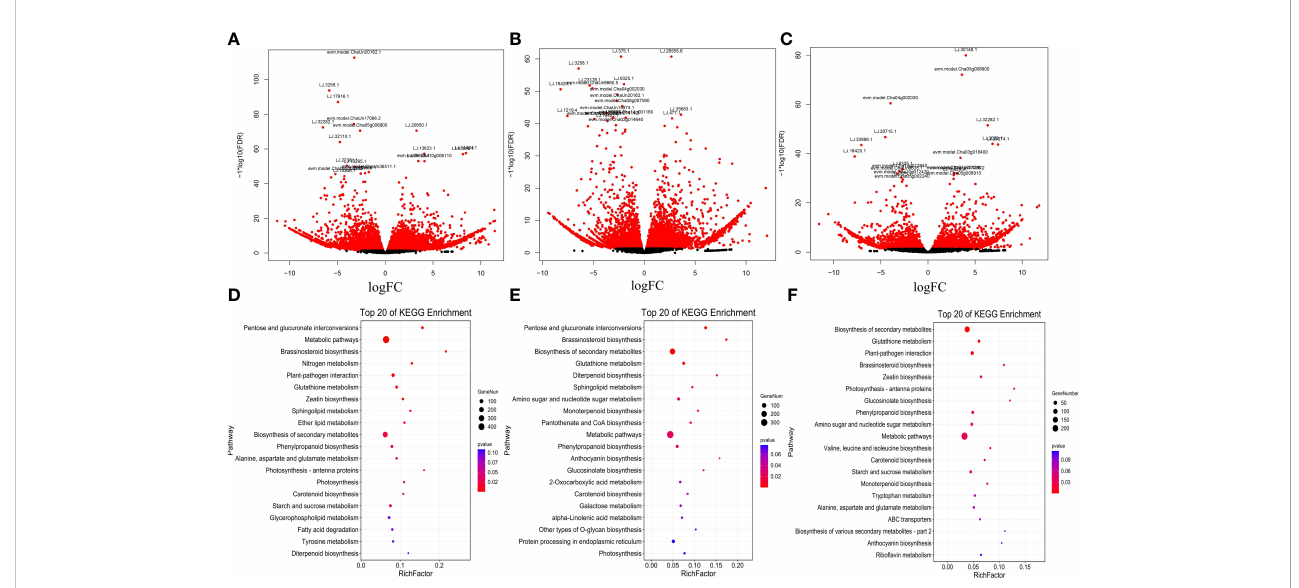
FIGURE 3 (A-C) Volcano map of DE-coding genes in LRs of tea plants under different nitrogen conditions. (A) LN vs CK. (B) HN vs CK. (C) HN vs LN. (d~f) KEGG pathways analysis. Top 20 pathways for the predicted coding genes of DE-coding genes. (D) LN vs CK. (E) HN vs CK. (F) HN vs